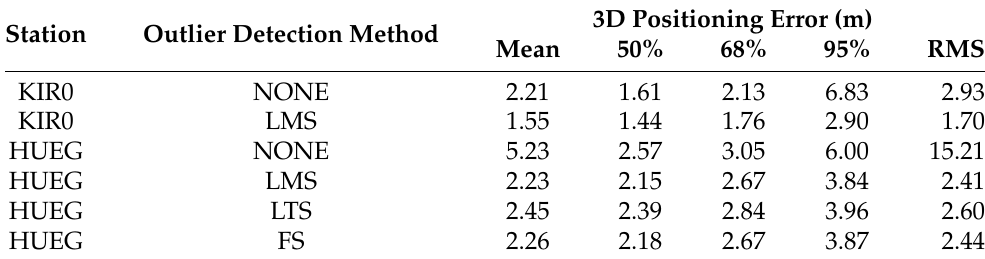
Figure 6. 3D position errors of KIR0 using the SPP. In red, the original PVT obtained without detecting and removing outliers. In blue, the PVT achieved detecting and filtering the outliers with LMS. Table 3. Mean, median, 68th and 95th percentiles and RMS of the positioning errors obtained for the two permanent stations, KIR0 and HUEG, applying different outlier detection methods. Note that the ‘NONE’ method only excludes satellites with an elevation lower than 5